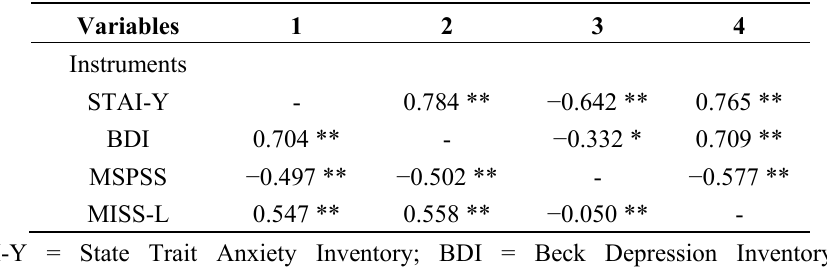
Table 6. Bivariate Pearson correlations among the instruments, in the two masculine populations: the superior triangle refers to the Italian participants ( N = 43), the inferior triangle to the Belgian participants ( N = 64).